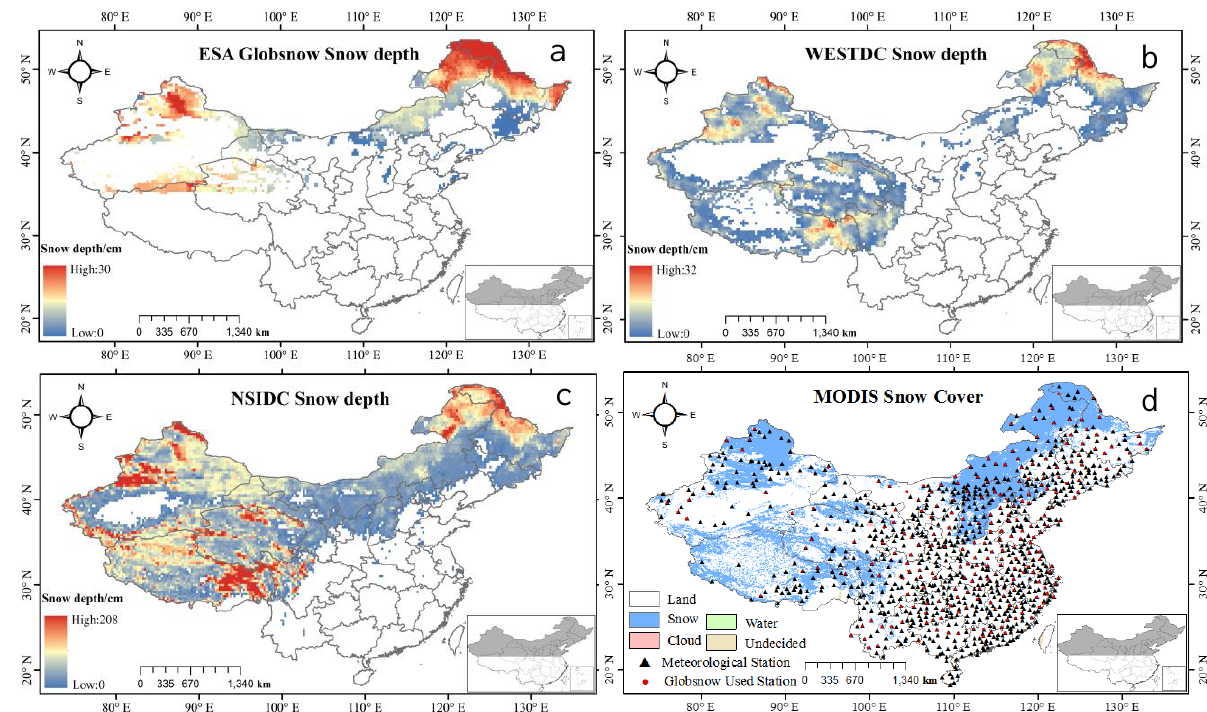
Fig.1. The Northern China daily SD data and the corresponding Modis snow cover in 1 January 2007. (a)-(c) are SD data from ESA GlobSnow, WESTDC and NSIDC. The data in (d) is the obtained from NSIDC.